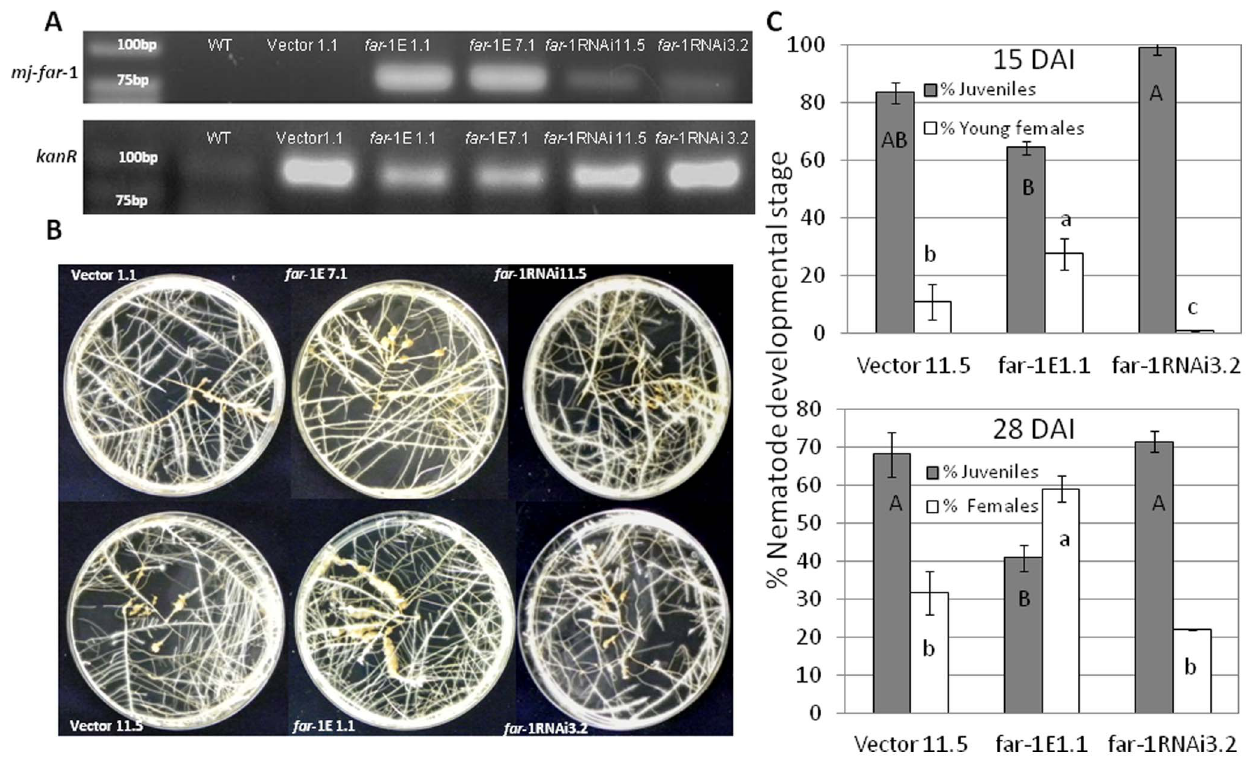
Figure 4. Constitutive expression of mj-far -1 in tomato hairy roots increases roots susceptibility to infection by the RKN M.javanica . A. RT-PCR confirmation of mj-far-1 (upper gel) and kanR (lower gel) expression in tomato hairy roots lines far -1 E1.1, far -1 E 7.1, far-1 RNAi3.2 and far-1 RNAi11.5 compared with the respective control Vector 1.1 and WT 870. The expected size of the PCR product is 96 bp for the mj-far -1 and 81 for kanR . RT-PCR was performed on total RNA isolated from non infected transformed tomato hairy roots and WT 870 roots. B. Increased susceptibility of tomato hairy roots expressing mj-far -1 ( far-1 E1.1 and far-1 E7.1) is accompanied by expanded galling production compared with mj-far-1 dsRNA- expressing tomato hairy root lines ( far-1 RNAi3.2 and far-1 RNAi11.5) and vector control (Vector 1.1. and Vector 11.5). C. Meloidogyne susceptibility/ resistance of vector transformed roots and transgenic tomato roots expressing mj-far-1 , or mj-far-1 dsRNA-expressing lines, was measured as nematode developmental stages counted at 15 and 28 DAI. Roots were inoculated with 200 sterile pre-parasitic J2s and then assessed for juveniles, young females and mature females under the dissecting scope following staining with acid fuchsin dye. Note the significant ( P # 0.05) increase in percentage of young females at 15DAI and increase in percentage of mature female at 28DAI in roots overexpressing mj-far-1 in comparison with vector control roots. Data are expressed as means of 25 plants from each line; the experiment was repeated three times, giving consistent results. The percentage of each developmental stage is represented by a mean 6 standard error. Different letters above the bars denote a significant difference ( P # 0.05, analysis of variance) between tomato roots lines analyzed by Tukey-Kramer multiple comparison tests.